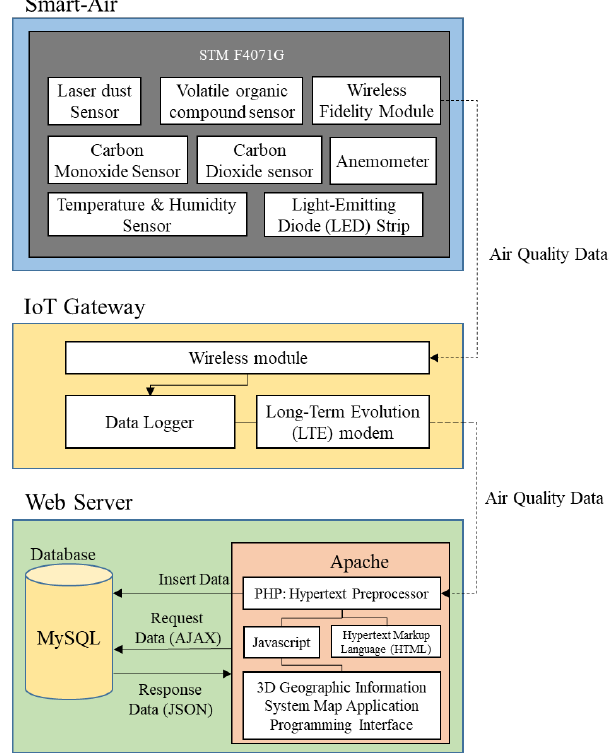
Figure 1. A configuration diagram of the Internet of Things based air quality monitoring system.